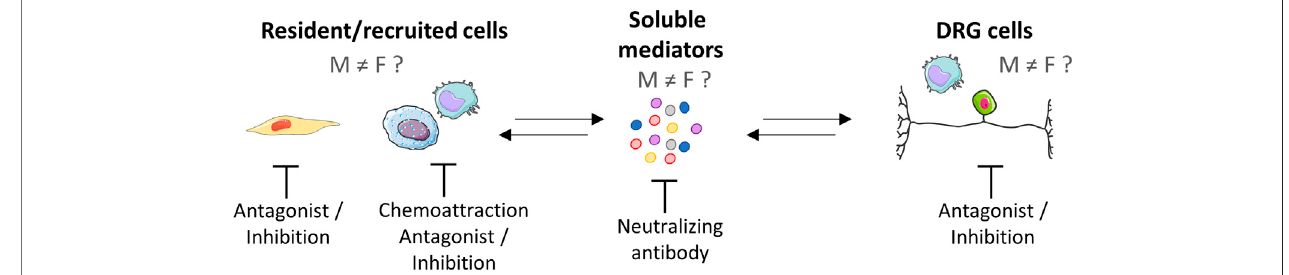
FIGURE 4 | Peripheral neuroimmune interaction and potential pharmacological targets. The neuroimmune interaction is a bidirectional process that can be mediated by soluble factors that drive a complex crosstalk among nerves and immune cells. Studies evaluating sex differences in this context are emerging and have found differences between the sexes. Potential pharmacological targets are represented, e.g., resident cells (synovial fi broblasts and macrophages), recruited immune cells (macrophages and mast cells), soluble mediators, and neurons. As differences in neuroimmune interaction have already been described, differences in the therapeutic approach between men and women should be addressed in future research. Created with Smart. Servier ®